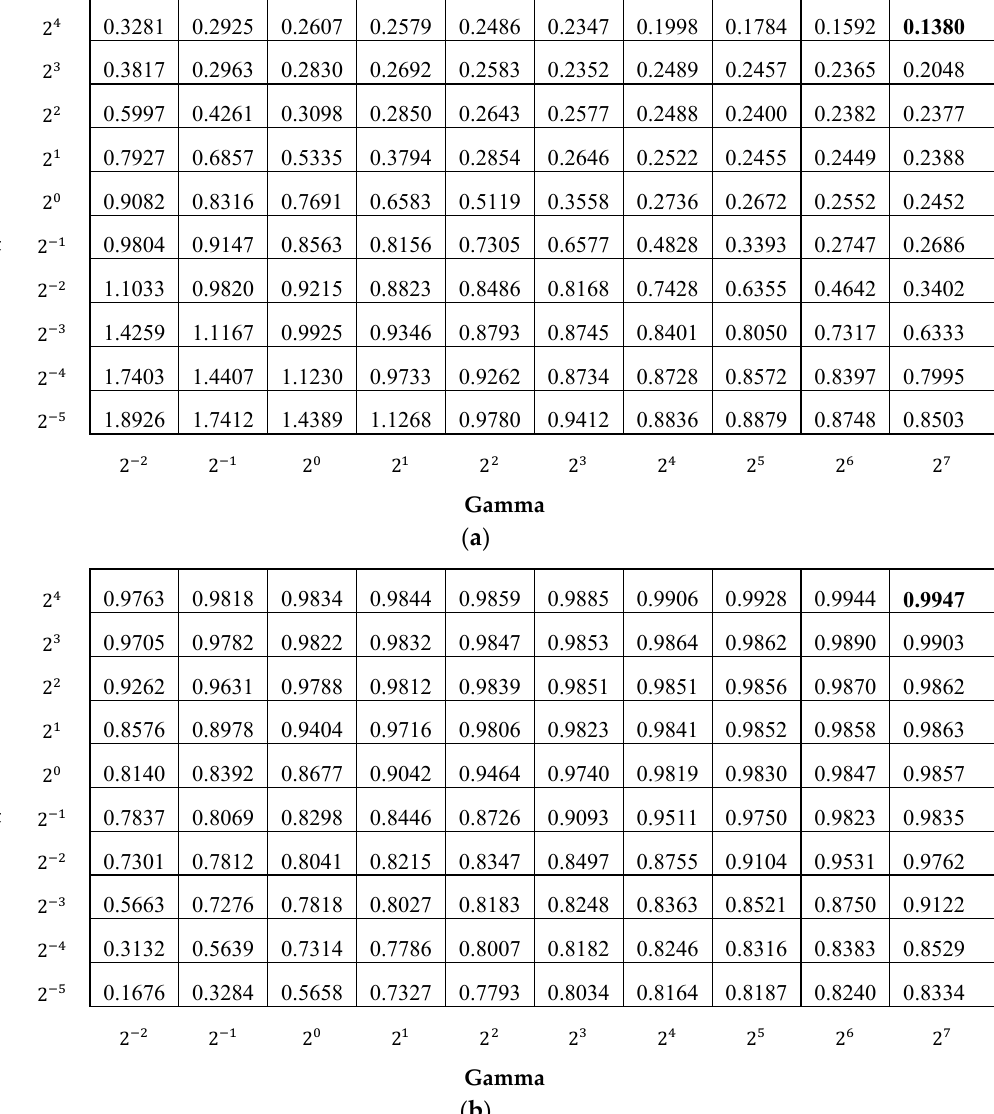
Figure 14. The mean score in the whole area of: ( a ) positioning accuracy and ( b ) CV.